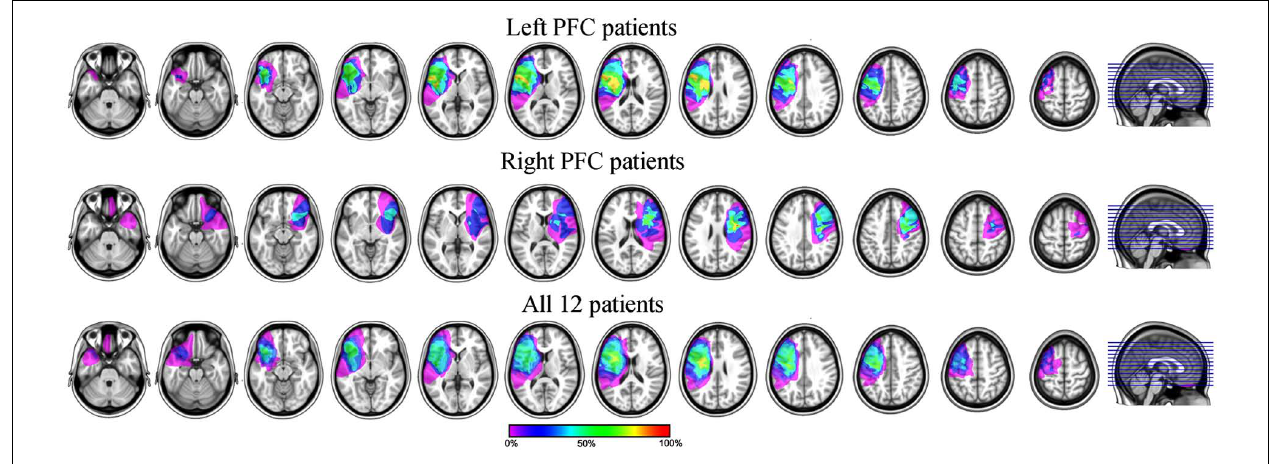
FIGURE 1 | Lesion overlapping of the six left (top) and six right (middle) and all (bottom) PFC patients included in the analyses. For the bottom row, the lesions of the right PFC patients were mirrored on the left side of the brain.